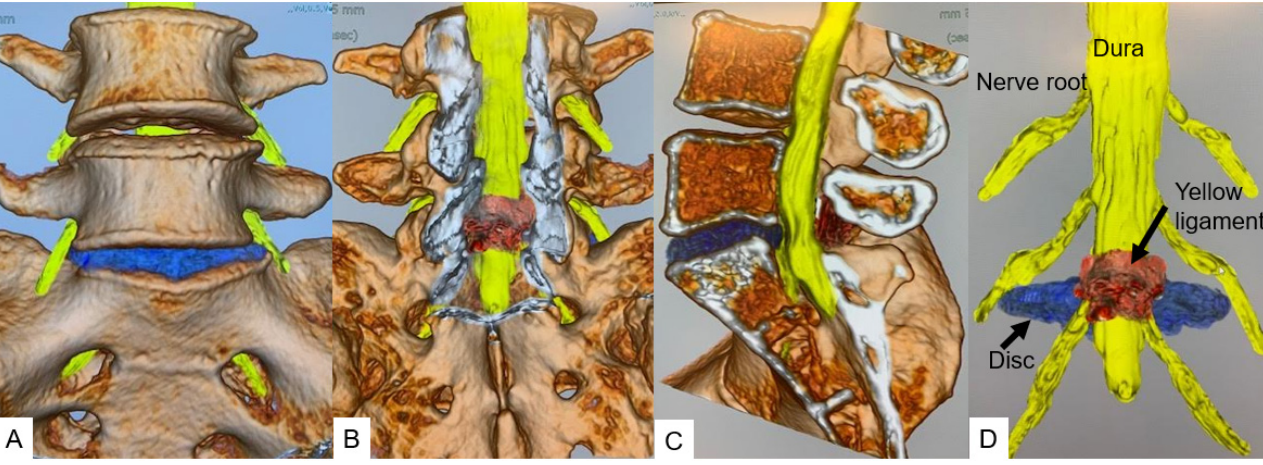
Figure 6. A 46-year-old male, left L5/S1 foraminal/extraforaminal disc herniation. ( A ): Anterior view. ( B ): Posterior view. ( C ): Lateral view. ( D ): Without bony structure.